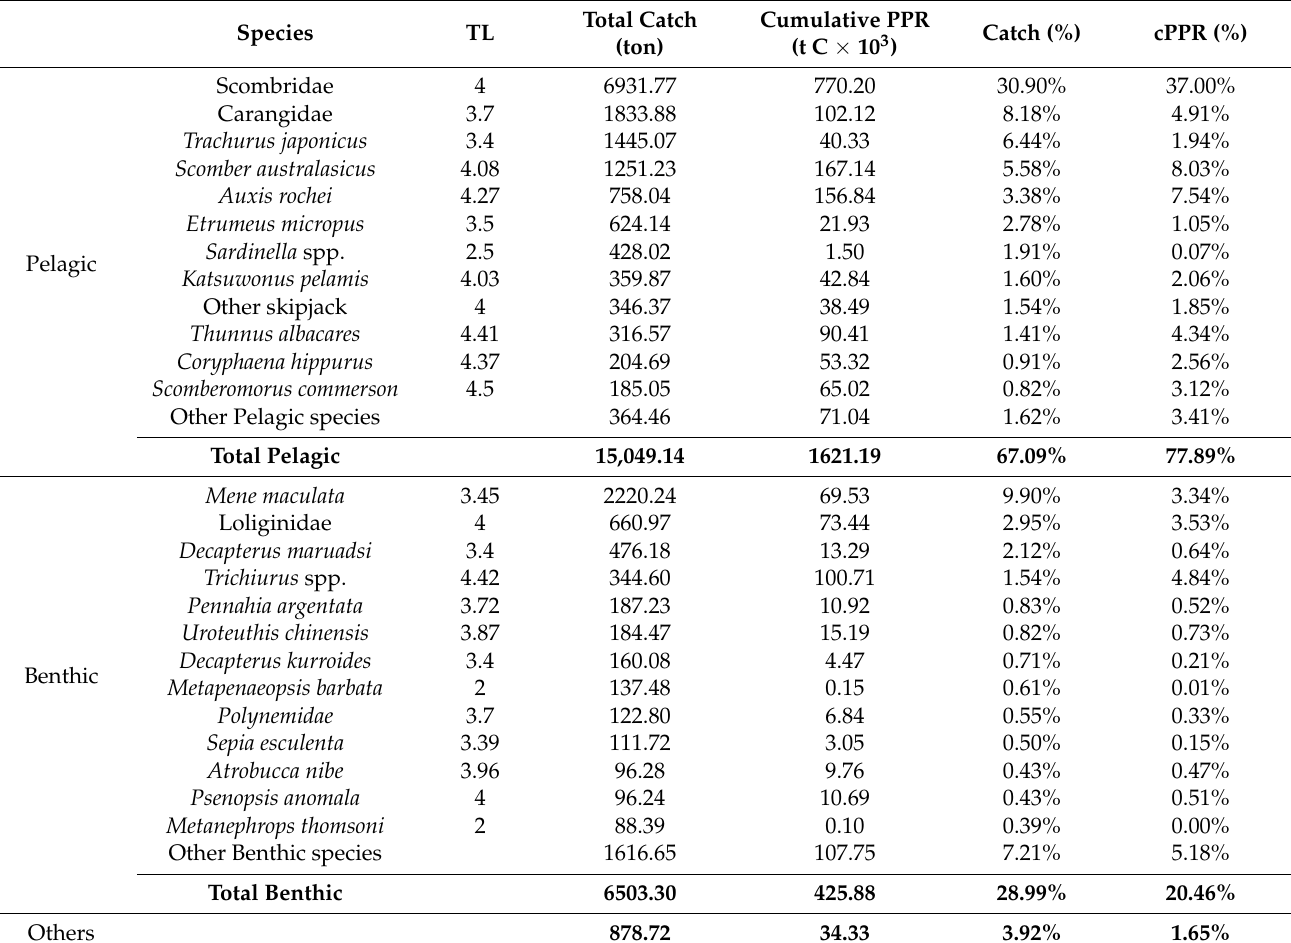
Table 1. The 12 pelagic and benthic species accounting for the highest proportion of total catch and primary production required in the Taiwan Bank